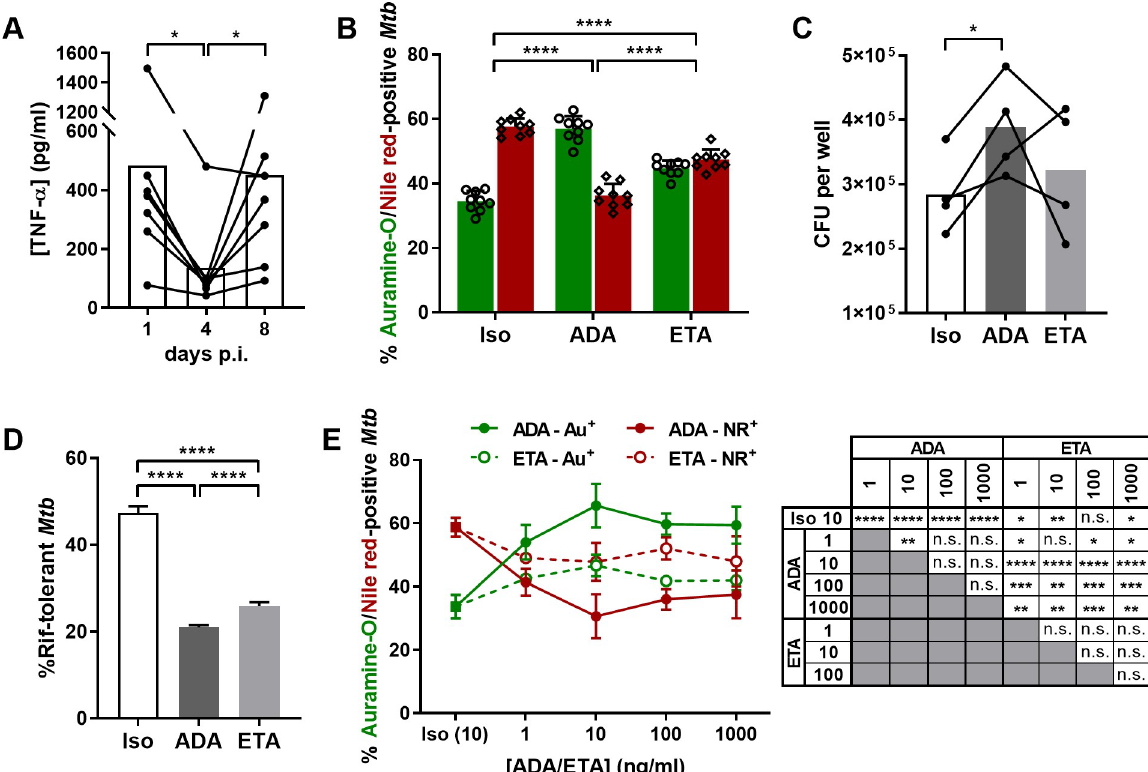
Fig 3. Unequal interference of TNF- α -targeting biologics ADA and ETA with granuloma-induced Mtb dormancy does not relate to differential bioavailability. (A) TNF- α concentration in supernatants on days 1, 4 and 8 post-infection with Mtb H37Rv (values for 7 independent donors are represented by line-connected circles and bars picture the mean concentration). Statistical analysis was performed using a Wilcoxon paired test. (B-D) At day 4 post-infection, granulomas were exposed for four additional days to an isotype control (Iso), adalimumab (ADA), or etanercept (ETA) at 10 ng/ml. (B) Percentages of auramine-O- (green) and Nile red-positive (red) Mtb quantified by fluorescence microscopy (mean ± SEM from 9 independent donors). (C) Mtb bacterial load quantified by CFU assessment (values for 4 independent donors are represented by line-connected circles and bars picture the mean concentration). Statistical analysis was performed using a paired t test. (D) Percentage of rifampicin (Rif)-tolerant Mtb quantified by CFU (mean ± SEM from 2 independent donors). (E) Percentages of auramine-O- (green) and Nile red-positive (red) Mtb quantified by fluorescence microscopy following four days of exposure to Iso (full squares), ADA (full circles/continuous line), or ETA (open circles/dotted line) at the indicated concentrations (mean ± SEM from 2 independent donors). Unless stated differently, statistical analysis was performed using a generalized linear mixed-effects model; n.s., not significant; � , p < 0.05; �� , p < 0.01; ��� , p < 0.001; ���� , p < 0.0001.